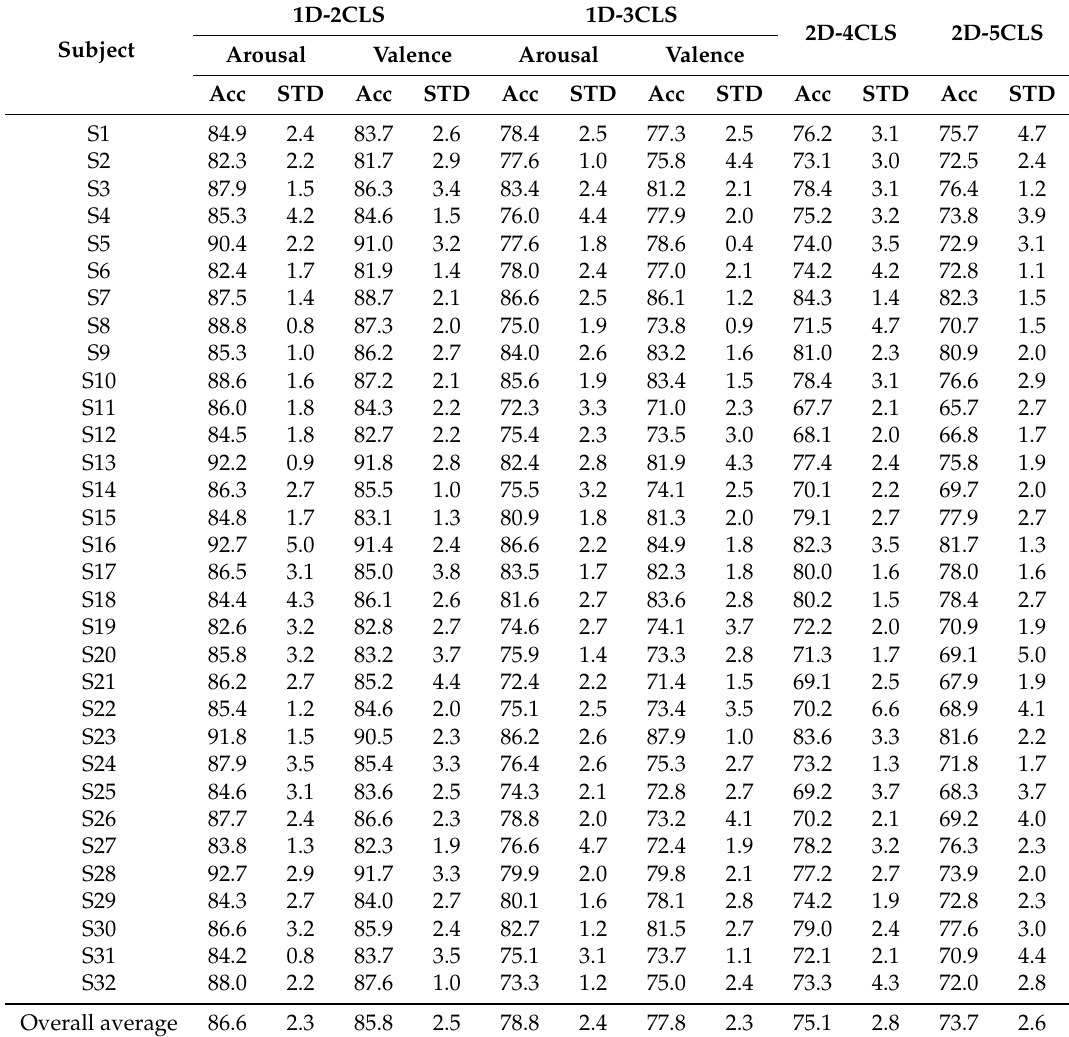
Table 8. The accuracy and standard deviation values computed for each subject using the top 25% of the features extracted form the EEG channels of C 4 . STD represents the standard